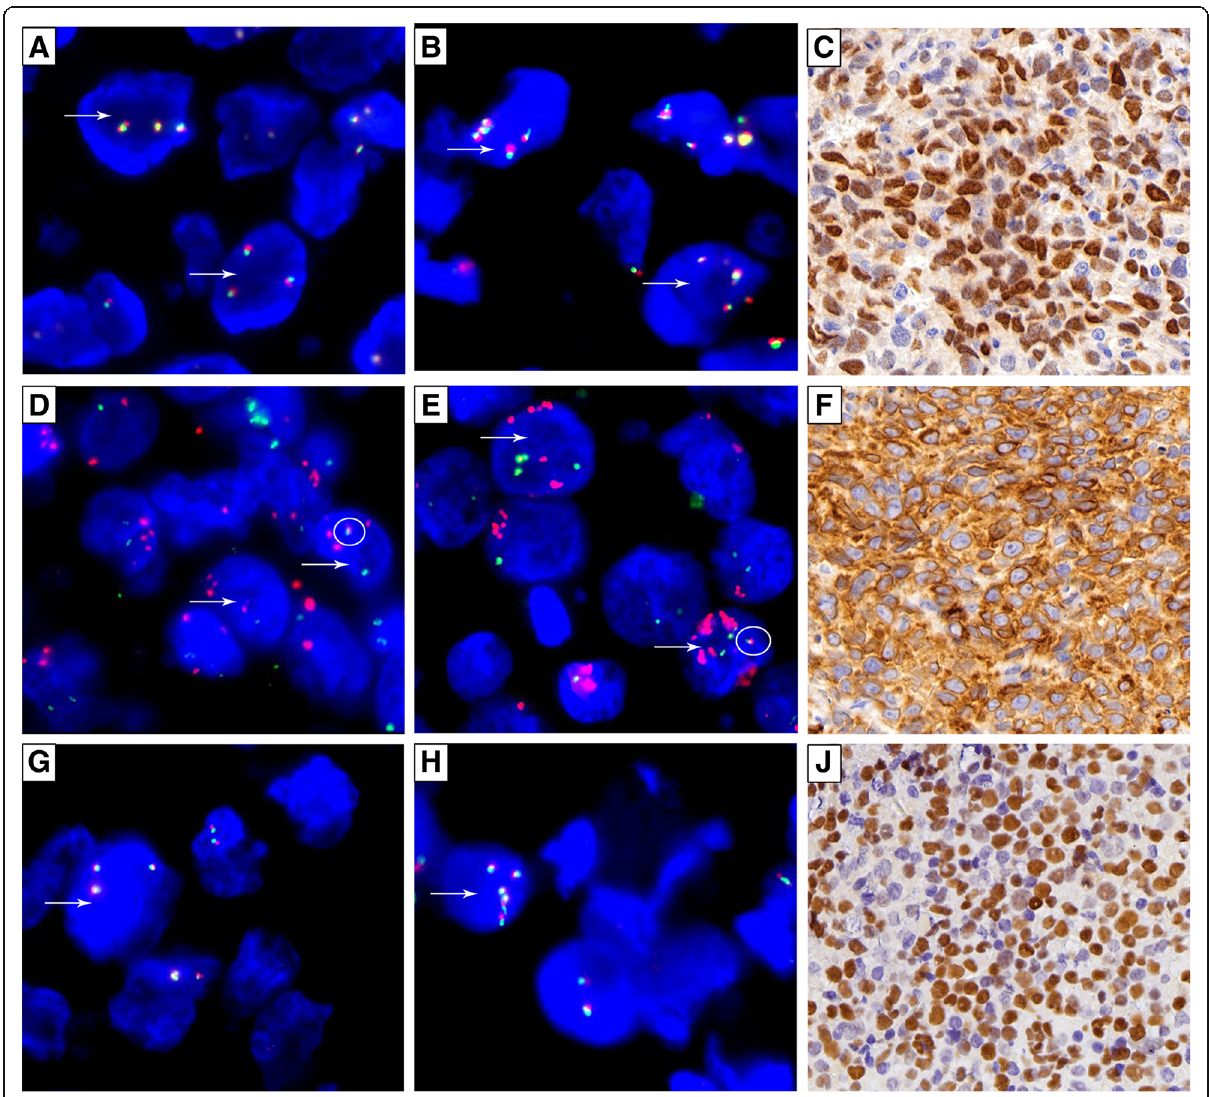
Fig. 1 Extra copies and protein expression levels of MYC, BCL2 and BCL6. White arrows indicate the gain of MYC ( a ), BCL2 ( d ), BCL6 ( g ) and amplification of MYC ( b ), BCL2 ( e ) and BCL6 ( h ). White circles represent BCL2 translocation. Patients with both BCL2 extra copies and rearrangement are shown ( d , e ) (×1000). Immunohistochemistry showed positive expression of MYC ( c ), BCL2 ( f ) and BCL6 ( i ) (×